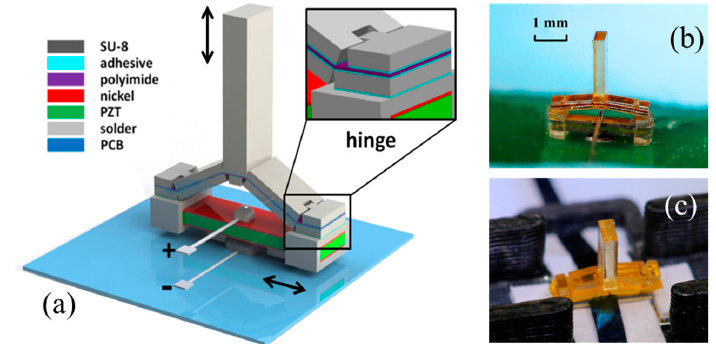
Figure 1. ( a ) Schematic diagram of a motion-amplifying actuator. The system comprises an